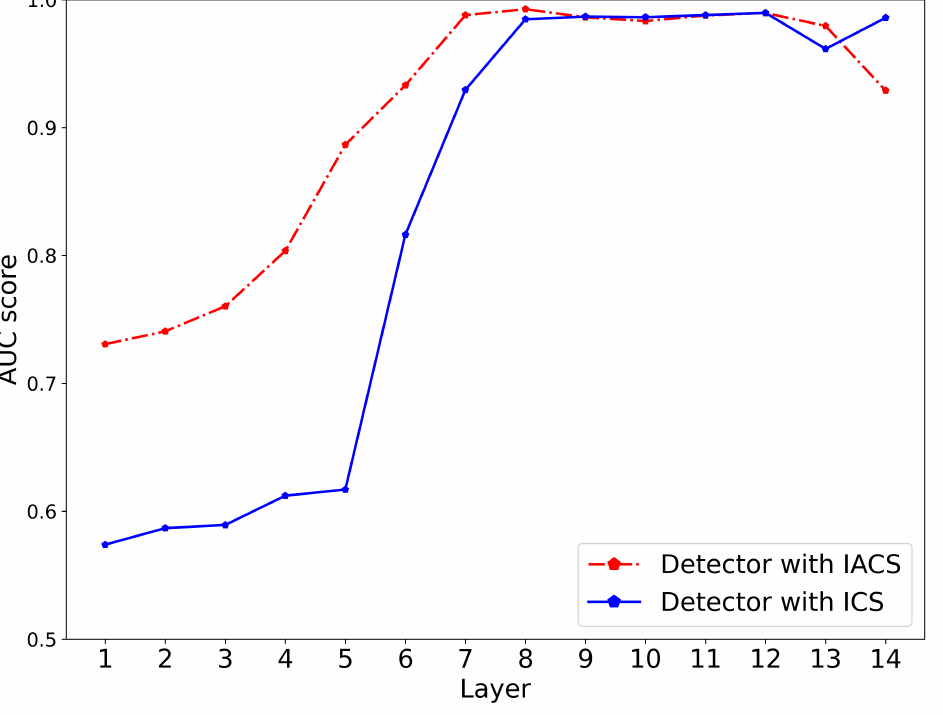
Figure 3. Single layer detector’s AUC score with IACS and